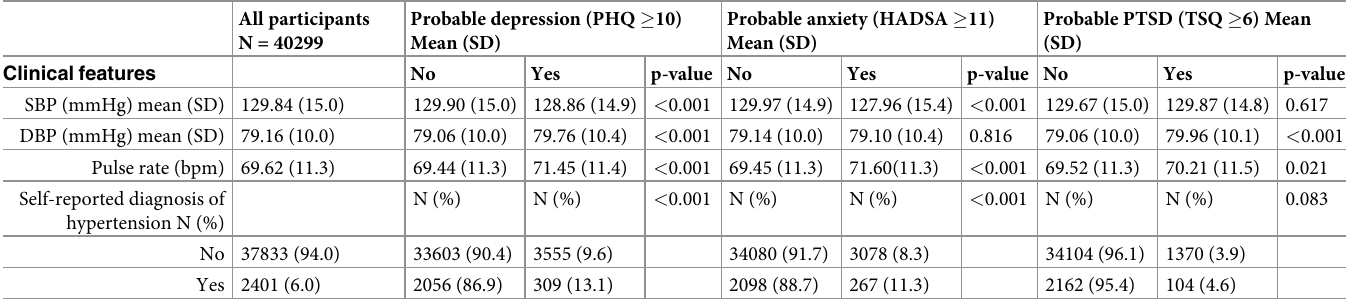
Table 2. Clinical features of police employees across probable mental